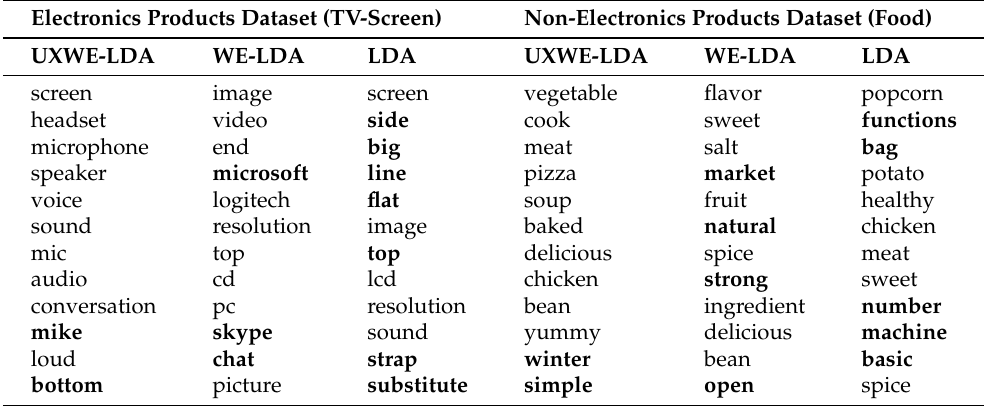
Table 3. Example topics generated by UXWE-LDA, WE-LDA, and LDA. The bold text shows an error.